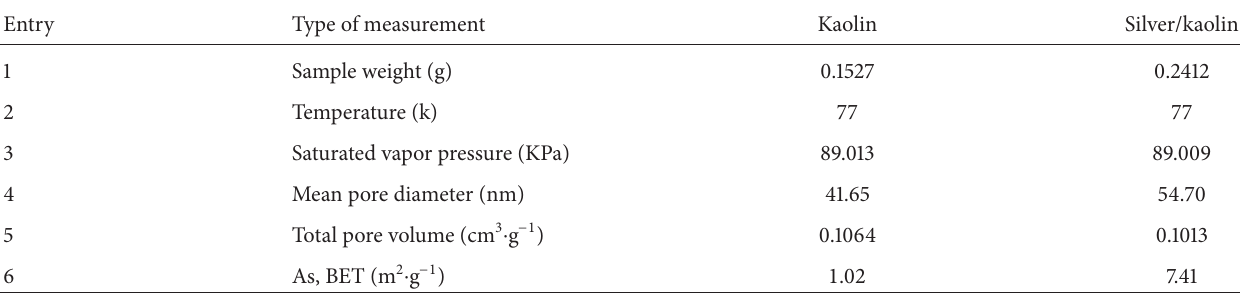
Table 1: Study of BET tests of Kaolin and Kaolin/Ag nanocomposite.